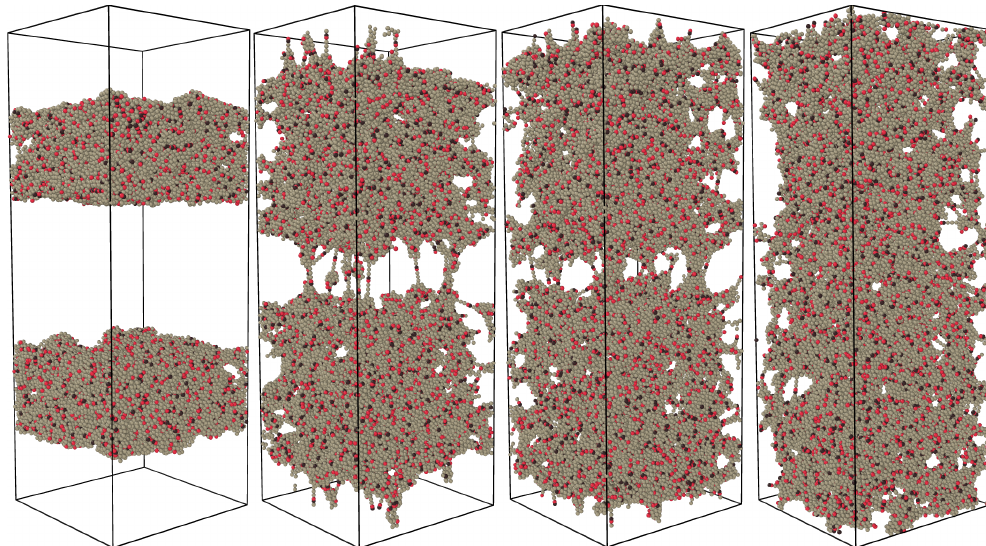
Figure 2. Visualization of the formation of bridges between the two halves after healing times t sh = { 0;0.017;0.042;0.42 } τ sw . The graphics were produced using energy minimization after a 40% vertical strain, with a small monomer–monomer attraction to clear up the view. At t sh = 0, the material is completely separated into two pieces, but swaps are rapidly healing the fracture. Already at t sh = 0.042 τ sw , traces of the fracture are only visible after straining. From t sh = 0.42 τ sw , the healed cut is indistinguishable from the